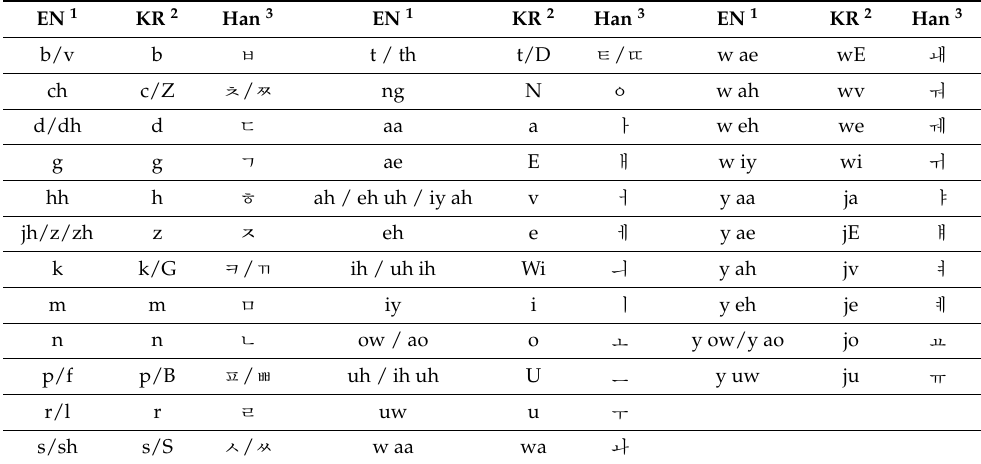
Table 2. Phoneme c onversion between English and Korean. Table 2. Phoneme conversion between English and Korean.